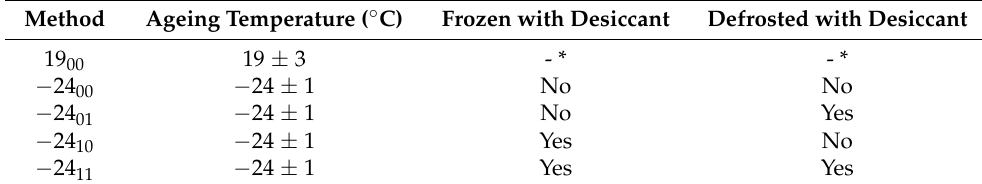
Table 1. Methods: the freezing and defrosting routes for the PLA. Method Ageing Temperature ( ◦